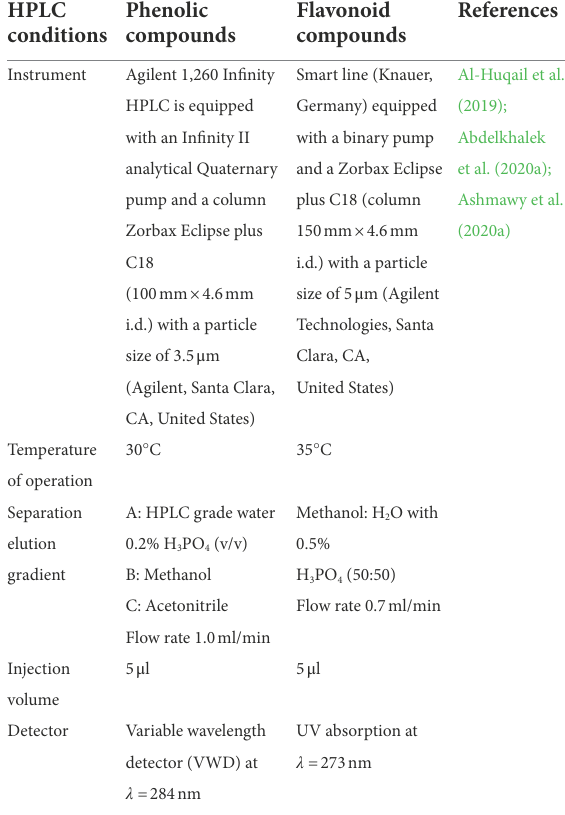
TABLE 1 HPLC conditions and operations used to detect the phenolic and flavonoid